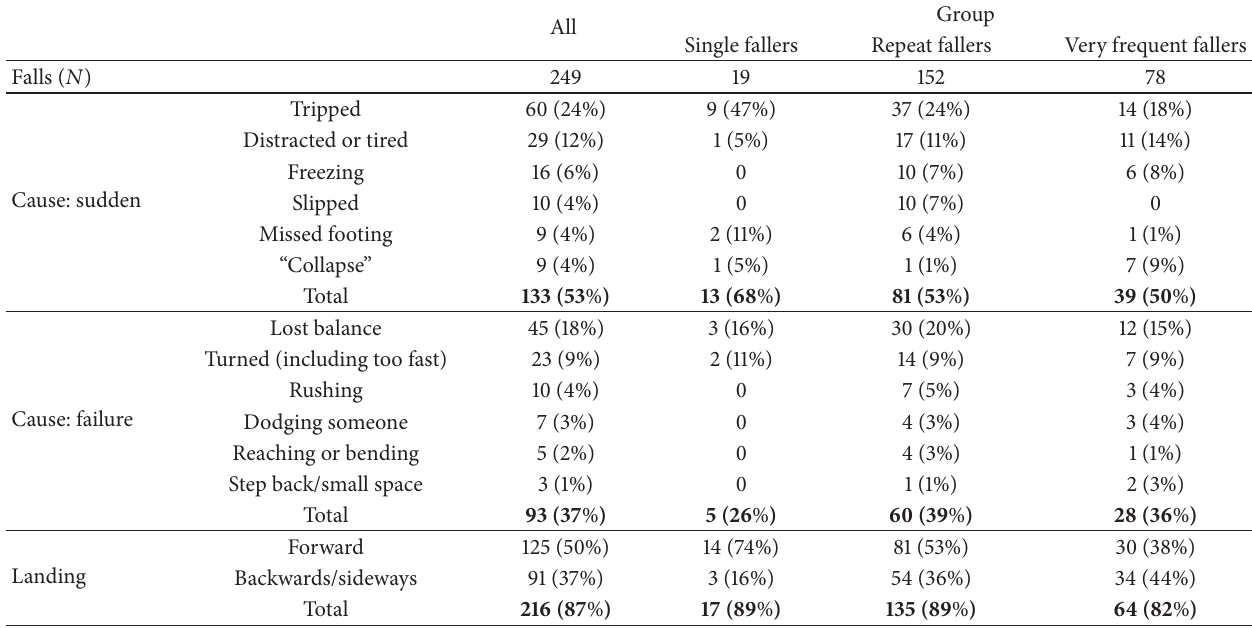
Table 3: Falls beyond home: causes and landings ( 𝑁 = 249 ).